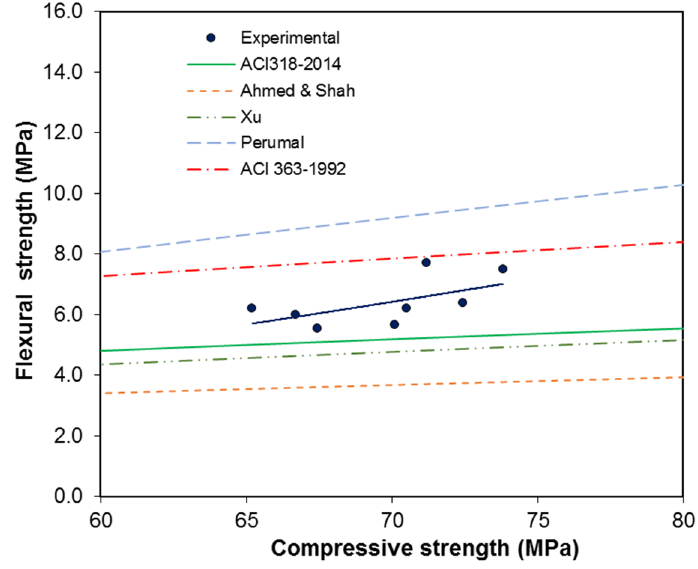
Figure 15. Compressive strength vs. flexural strength of FRC.